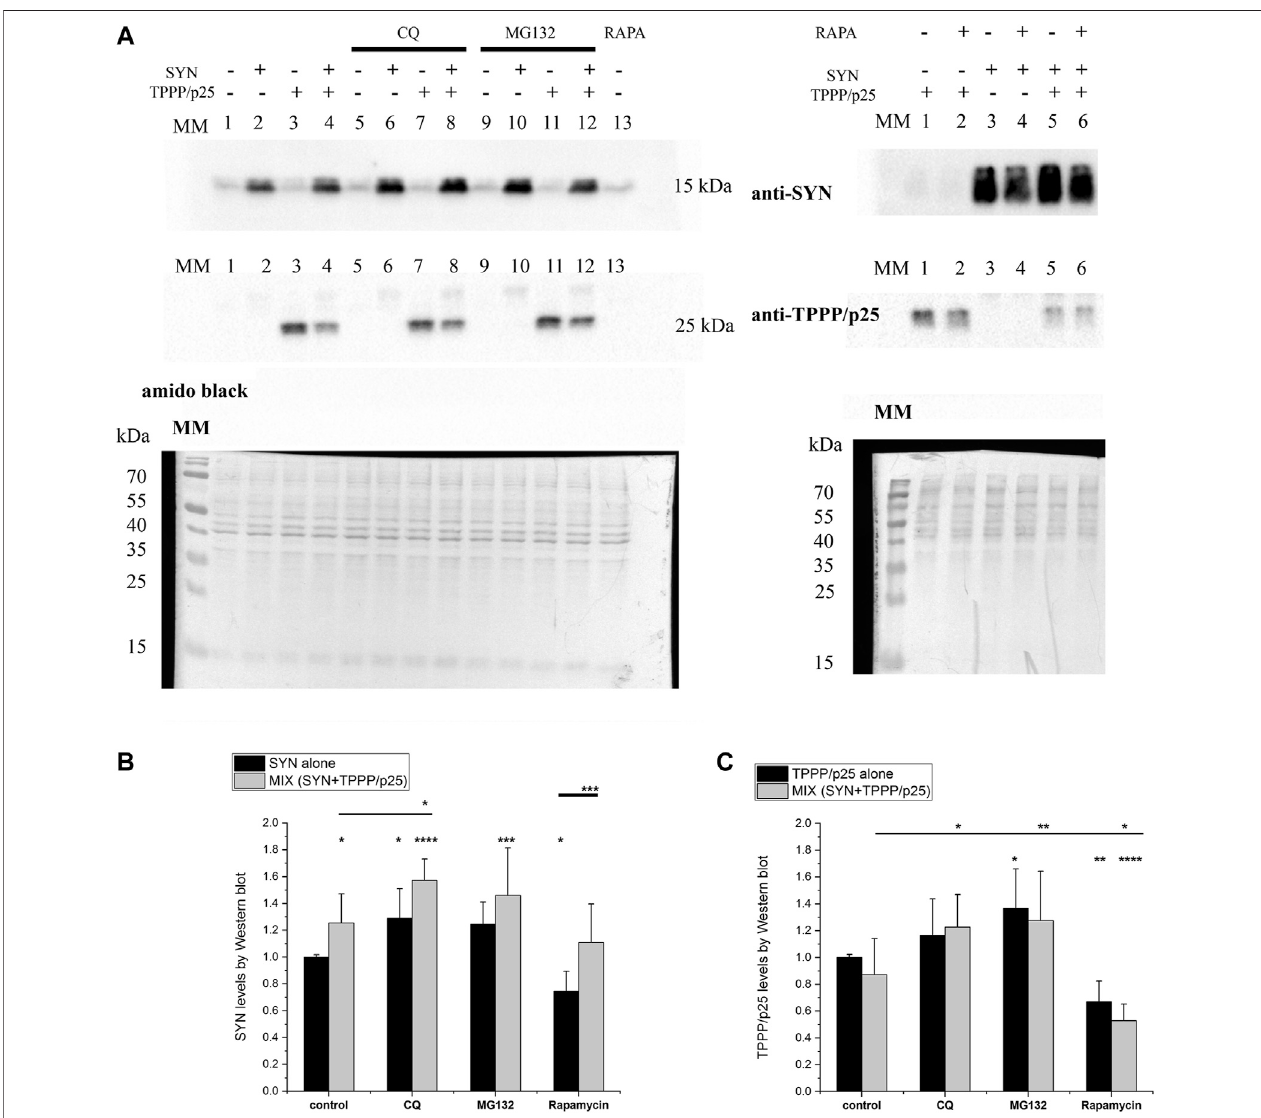
FIGURE 7 | Level of the degradation-resistant hallmark proteins in the course of autophagy. TPPP/p25 and/or SYN (at 80 nM and 800 nM concentrations, respectively) were added to medium of the HeLa cells. The concentrations of CQ, rapamycin (RAPA) and MG132 are given in the Materials and Methods ( Table 1 ). (A) Representative Western blots for quanti fi cation of the SYN and/or TPPP/p25 amounts detected in the absence and presence of autophagy modulators. MM: molecular weight marker. Amido black solution was applied to stain the protein bands (total protein). (B, C) Proteins levels of the degradation-resistant SYN (B) and TPPP/ p25 (C) and their assemblies are quanti fi ed in the absence and presence of autophagy modulators by Western blot. Data are normalized with respect to the added hallmark protein alone (B: SYN, C: TPPP/p25), and presented as the mean ± SD of at least 4 independent experiments. Statistical comparisons were performed with one-way ANOVA followed by Tukey ’ s test (* p < 0.05, ** p < 0.01, *** p < 0.001, and **** p < 0.0001 as compared to control or as the lines